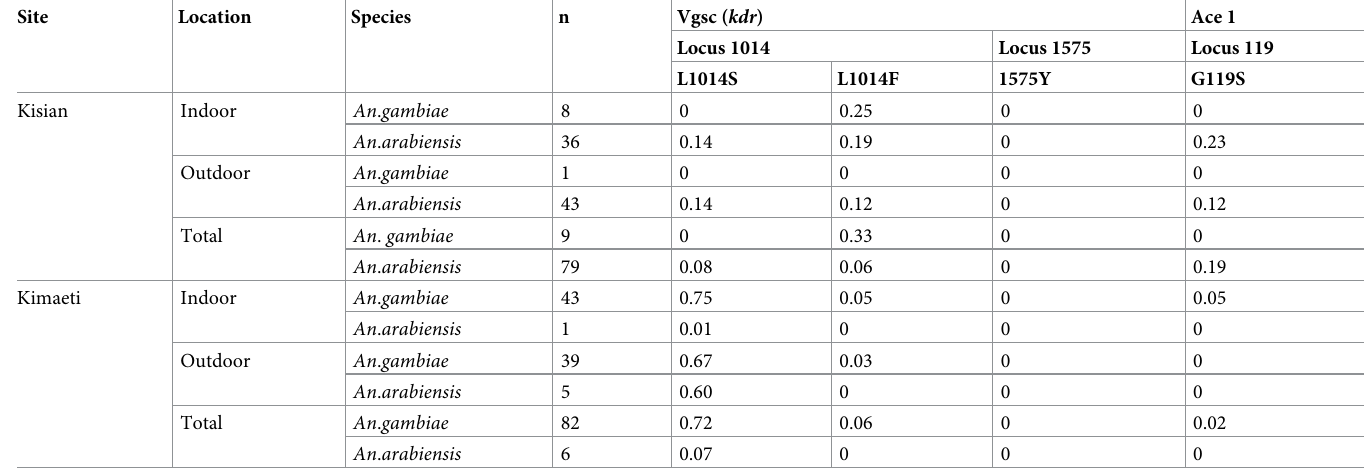
Table 2. Frequency of resistant alleles ( Kdr and Ace1-G119S ) in indoor and outdoor-resting An . gambiae s . s and An . arabiensis populations from Western Kenya. Site Location